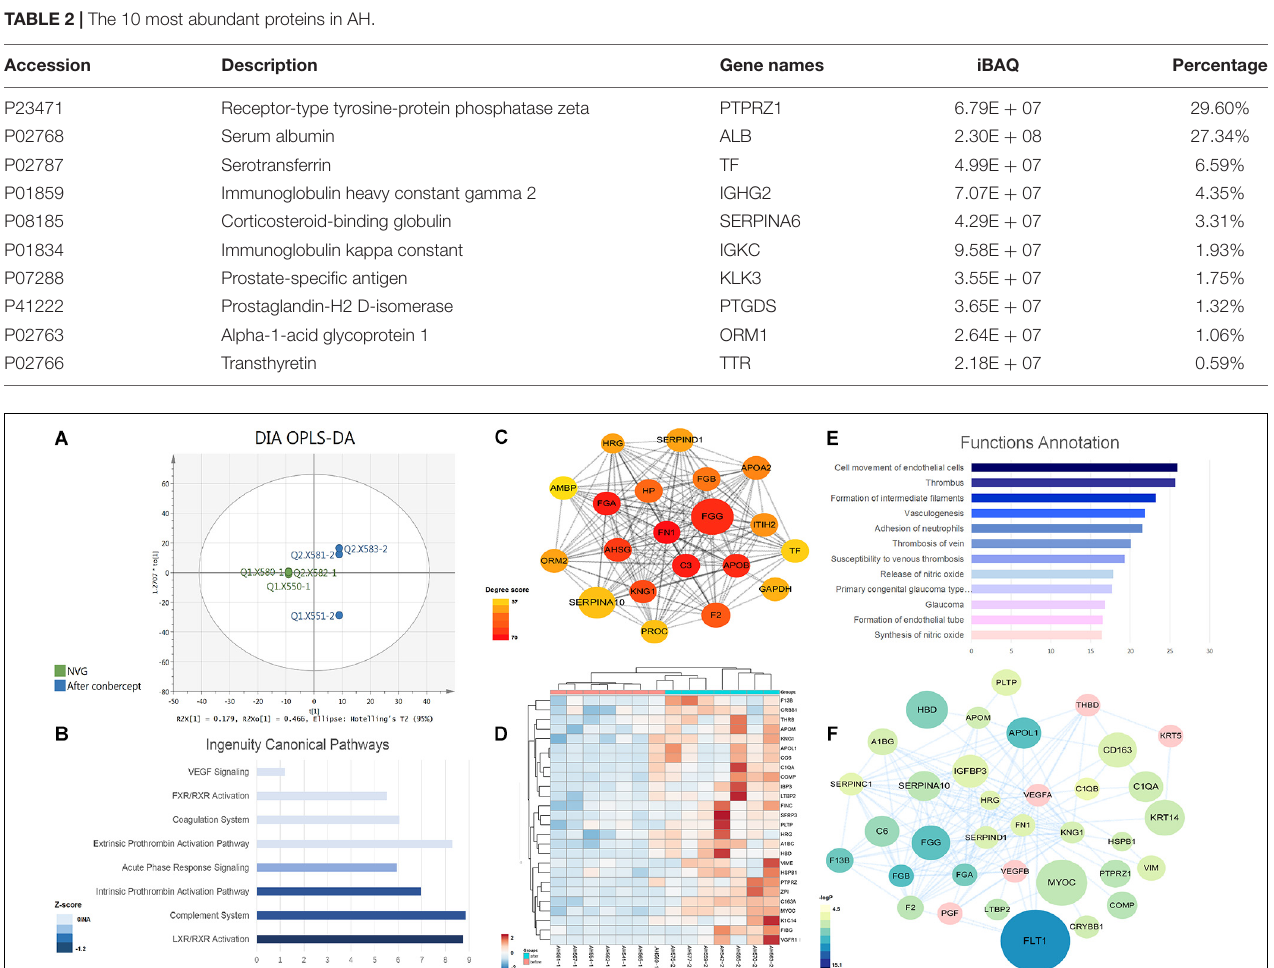
FIGURE 3 | The DEP analysis of the AH proteome in the NVG treatment with conbercept. (A) The orthogonal partial least squares discriminant analysis (OPLS-DA) score plot based on the DIA data of the AH proteome from NVG patients (green), and after conbercept treatment patients (blue). The mean center-scaling model ( P = 1.54857e-07). (B) The IPA ingenuity canonical pathway analysis of DEPs. (C) The subnetwork of DEPs with high node degree. (D) The hierarchical clustering based on the PRM data of the validated DEPs. (E) The function annotation of validated DEPs. (F) The network of validated